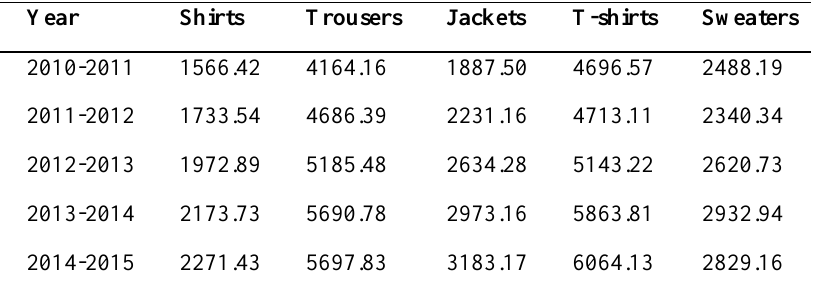
Table 2. Major apparel items exported from Bangladesh in Million USD. Shirts Trousers Jackets T-shirts